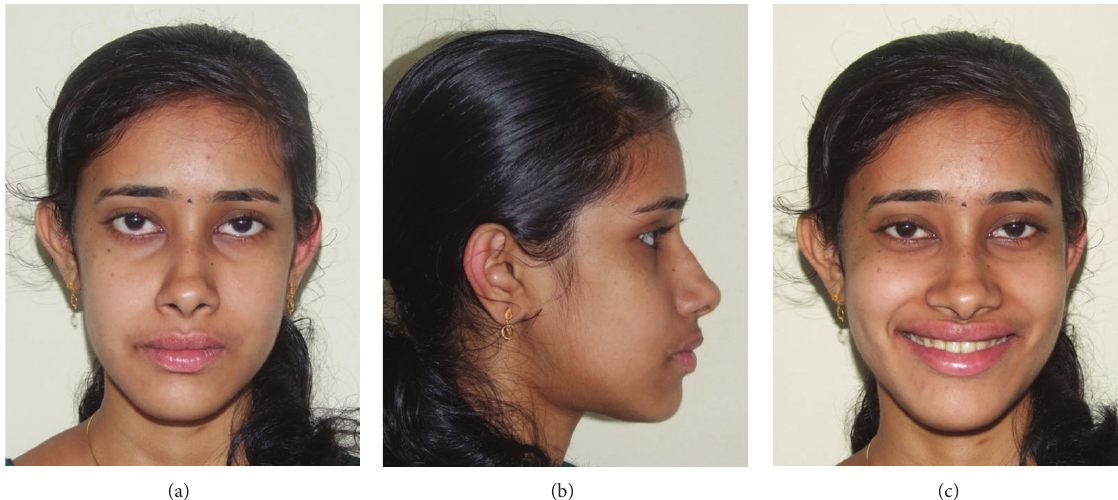
Figure 16: Posttreatment face: (a) frontal, (b) profile, and (c) smile.